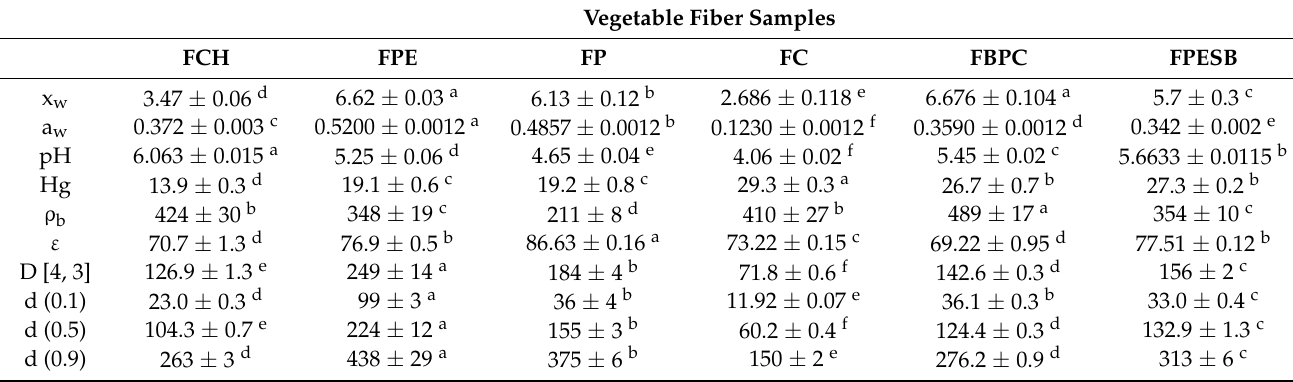
Table 2. Mean values ± standard deviation of moisture (x w ) (g w /100 g sample), water activity (a w ), pH (dispersions 10% w / v ), hygroscopicity (Hg) (g water/100 g dry solid), bulk density ( ρ b ) (g/L), porosity ( ε ), volume mean diameter D [4, 3] ( μm) and the standard percentiles d (0.1), d (0.5) and d (0.9) of the studied samples.